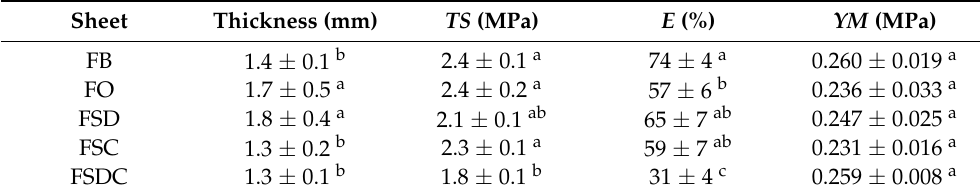
Table 4. Thickness and mechanical properties of a control (FB) and enriched sheets, incorporated with tucum ã oil (FO) and tucum ã oil encapsulated by spray drying (FSD), spray chilling (FSC) and the combination of both techniques (FSDC).